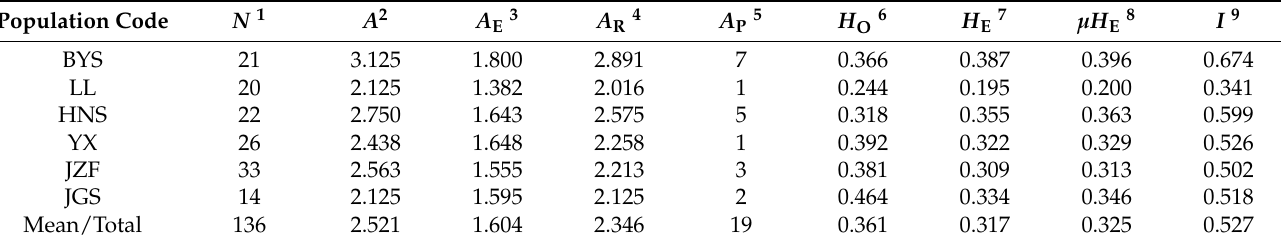
Table 3. Genetic parameters of six populations in S. tzumu .